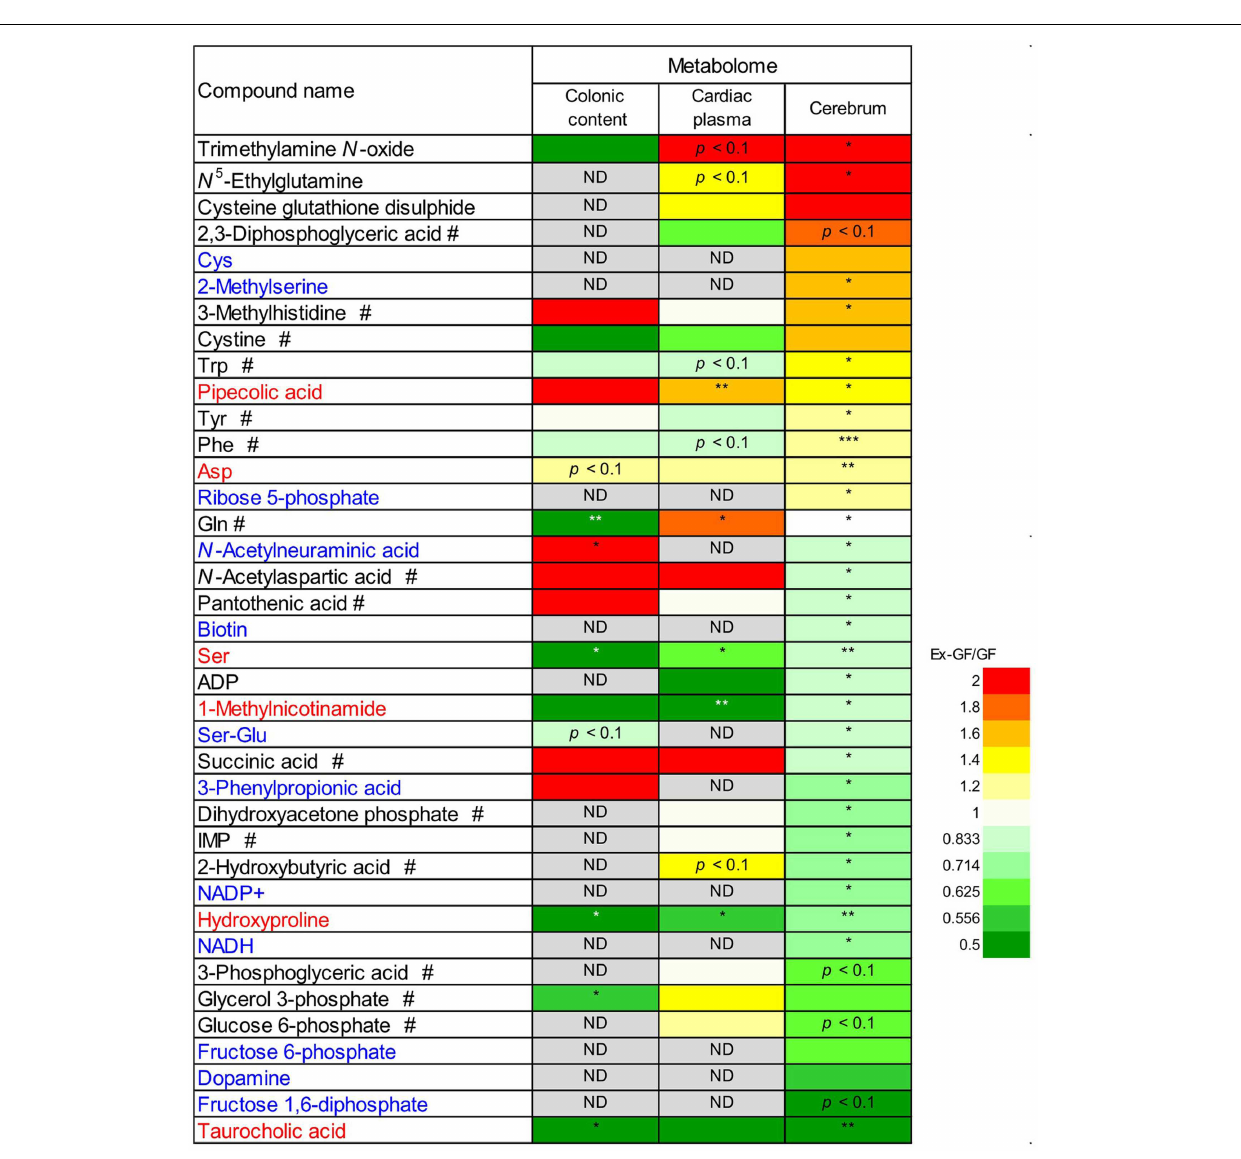
FIGURE 5 | Relative quantitative ratio (Ex-GF/GF value) comparisons of 38 metabolites between GF mice and Ex-GF mice, colonic luminal content, cardiac plasma, and the cerebrum . Metabolites shown in red have similar Ex-GF/GF ratios between the colonic lumen, cardiac plasma, and the